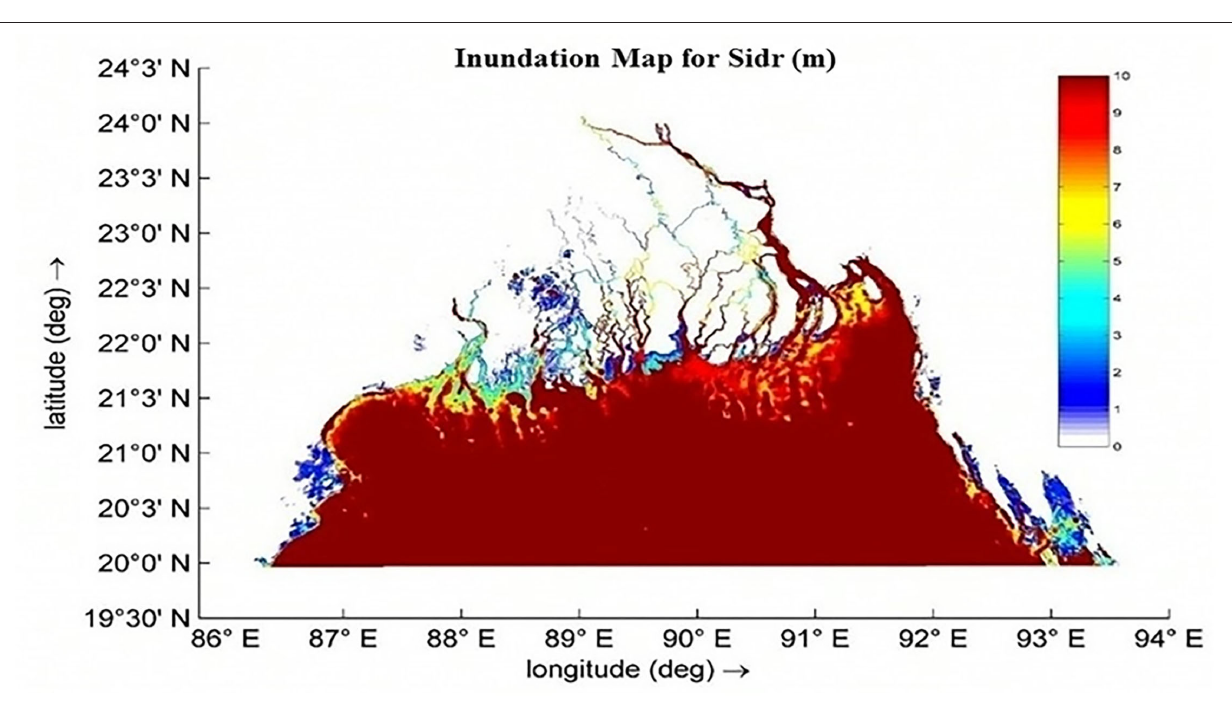
FIGURE 11 | Simulated storm surge inundation due to cyclone Sidr during landfall